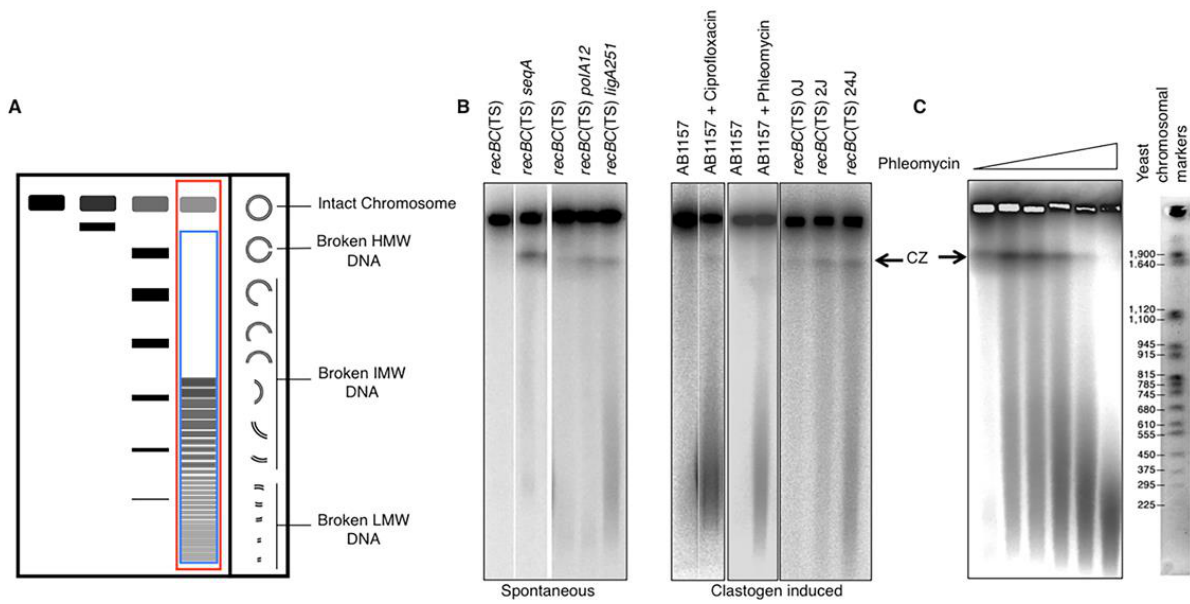
FIGURE 8: Fragmentation of bacterial chromosomes under various conditions. (A) Schematic representation of size-dependent migra- tion of linear DNA through PFGs. Note that the intact circular chromosome stays in the wells. Chromosomal fragmentation is quantified as the percentage of the total signal (well+lane, red rectangle) that enters the lane (blue rectangle), that is: [Signal in lanes x 100 / total sig- nal (well+lane)]. HMW, high molecular weight (≥2 mbp); IMW, Intermediate molecular weight (0.2 - 2.0 mbp); LMW, low molecular weight (≤0.2 mbp). (B) Spontaneous and clastogen-induced chromosomal fragmentation in E. coli . Typically, chromosomal fragmentation is detected in the recBC mutant, deficient both in repair of DSBs and in degradation of linear DNA. However, when fragmentation is mas- sive, it can be detected in wild type cells (such as ciprofloxacin- or phleomycin-induced fragmentation in AB1157 in these examples). Spontaneous fragmentation is measured under conditions when the recBC (Ts) mutants carry additional defects in SeqA, DNA polymerase I or DNA ligase [165, 167]. Clastogen-induced fragmentation is observed upon exposure to phleomycin and ciprofloxacin. Ultraviolet light, which affects only one strand of DNA, still causes significant fragmentation in recBC (Ts) background [166]. CZ, compression zone. (C) Pulsed field gel electrophoresis can be used to calculate the density of breaks in the chromosomal DNA if the average size of the resulting chromosomal fragments is